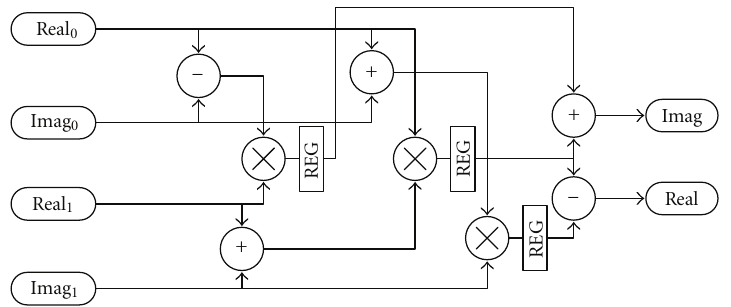
Figure 7: The pipelined complex multiplier.